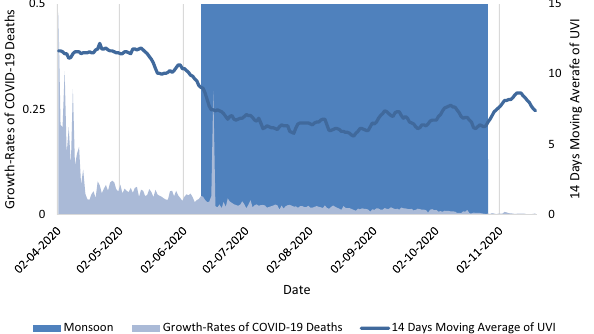
Figure 1. Illustration of the daily growth rates of COVID-19 deaths, Ultraviolet Index (UVI) and the monsoon season in Maharashtra, an administrative region in